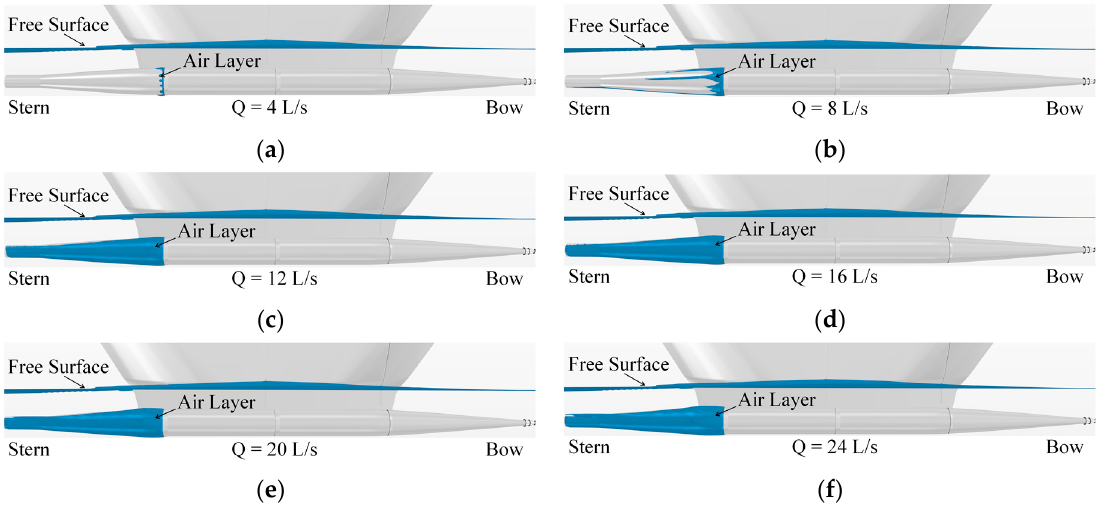
Figure 10. Air layer distribution with air injected from location L4: ( a ) Air fl ow rate Q = 4 L/s; ( b ) Air fl ow rate Q = 8 L/s; ( c ) Air fl ow rate Q = 12 L/s; ( d ) Air fl ow rate Q = 16 L/s; ( e ) Air fl ow rate Q = 20 L/s; ( f ) Air fl ow rate Q = 24 L/s.